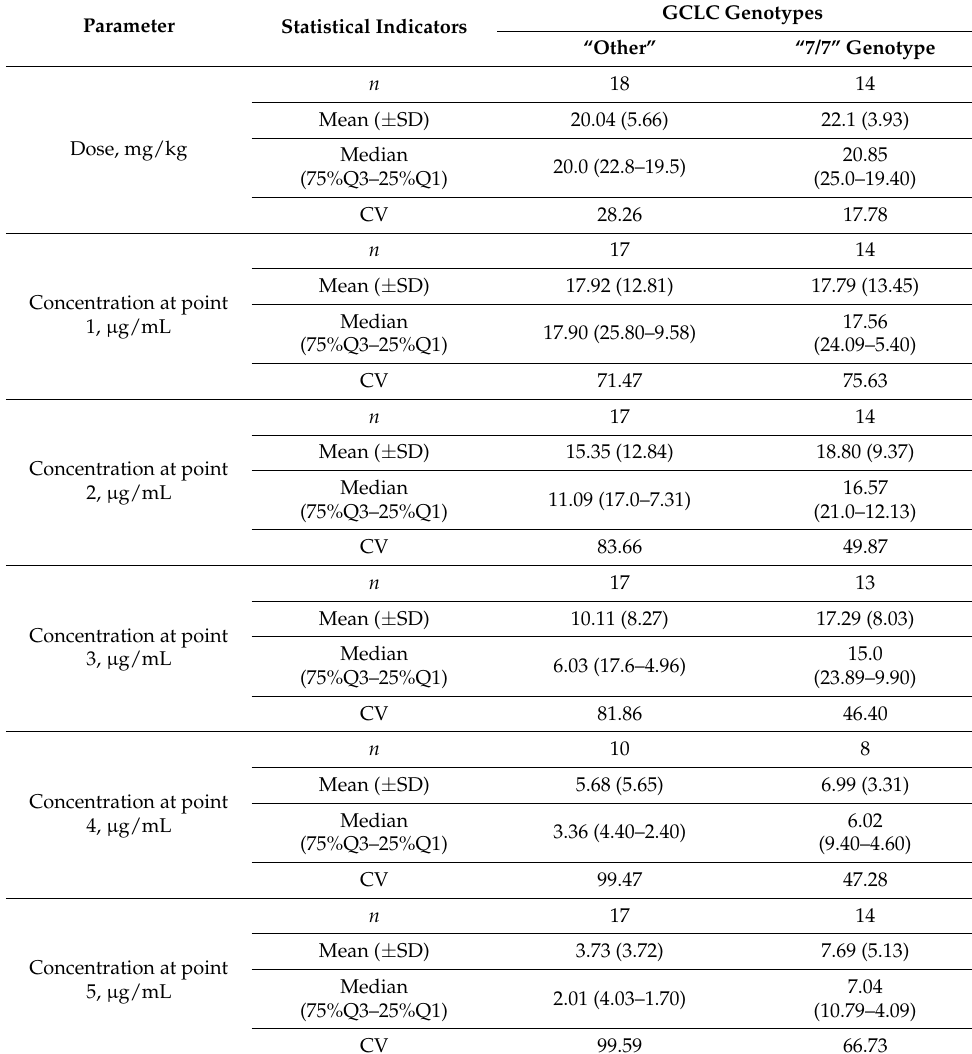
Parameters of the physical development of children with different variants of the TNR(GAG) polymorphism genotype of the GCLC gene are presented in the Supplementary Materials (Table S4). The pharmacokinetic parameters of CPF in children and adolescents with different variants of the GCLC gene are shown below in Table 14. Table 14. Pharmacokinetic parameters of ciprofloxacin in children and adolescents with different genotypes of the GCLC